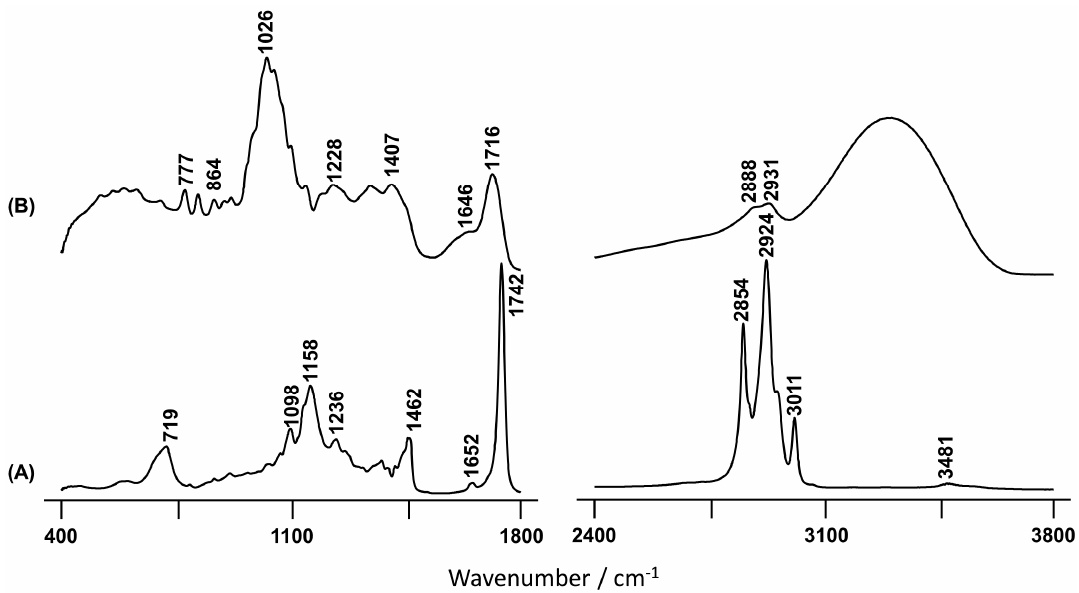
Figure 2. FTIR-ATR spectra of the BSO ( A ) and FBP ( B ) C. album berry extracts.